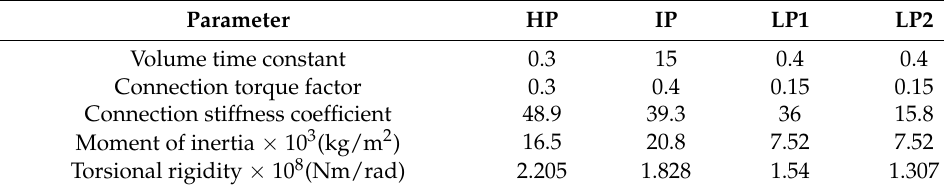
Table 2. Input parameters of steam turbine simulation module.